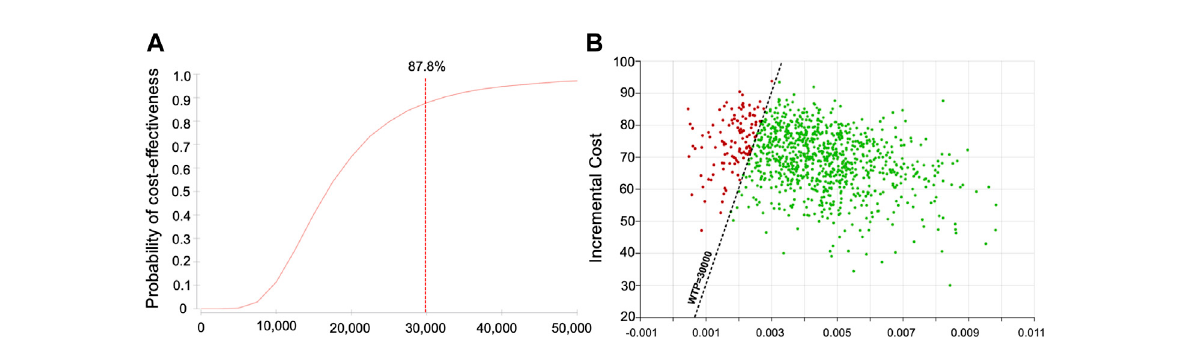
FIGURE 2 Results of probability sensitivity analysis [HLA-DQB1 (126Q), HLA-B (158T) and rs149104283] (A) Cost-effectiveness acceptability curve (B) Scatter plot for incremental cost and effectiveness: green dots indicate ICERs within willing to pay (WTP) threshold and red dots indicate out of the